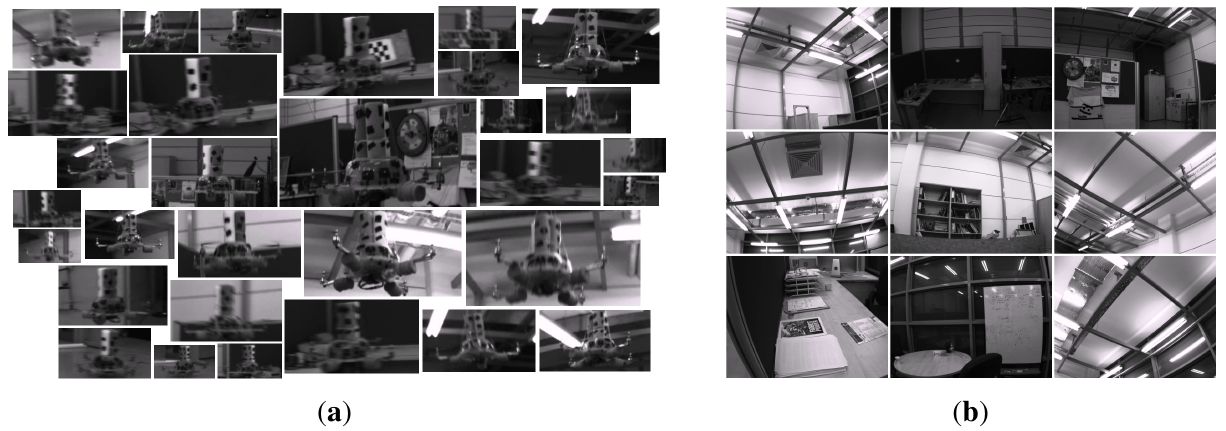
Figure 8. Example images from indoor ( a ) quadrotor and ( b ) background training image sets. Mostly the challenging examples are provided in the quadrotor